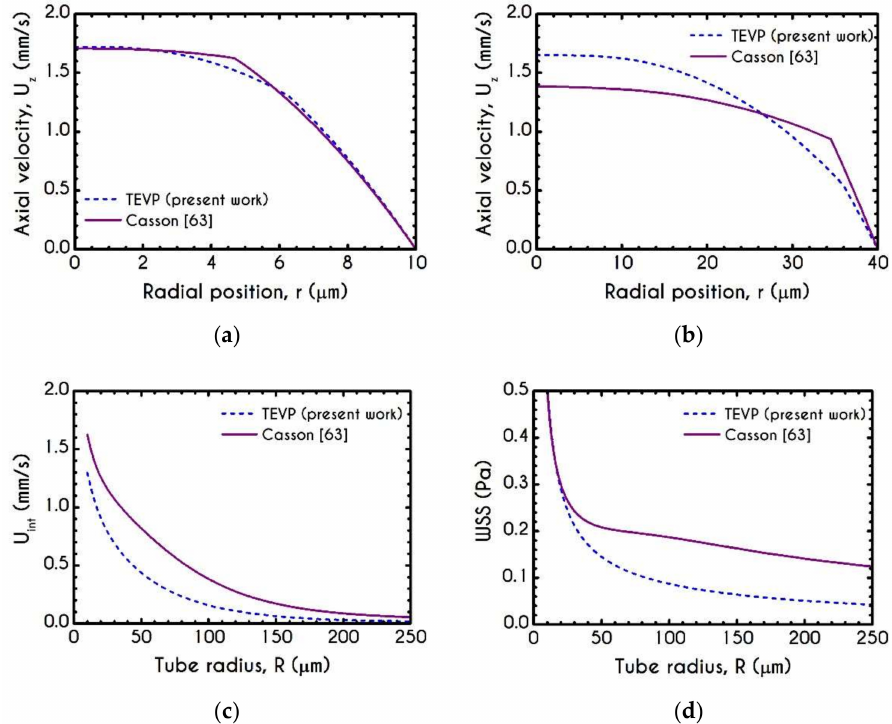
Figure 3. Comparison between the TEVP model with the inelastic model of Casson [63] regarding the velocity profiles within a microtube for ( a ) R = 10 µ m and ( b ) R = 40 µ m, ( c ) Interfacial axial velocity U int as a function of the tube radius and ( d ) Wall Shear Stress (WSS) with respect to the radius of the microtube. Here, H c = 45% and U mean = 1